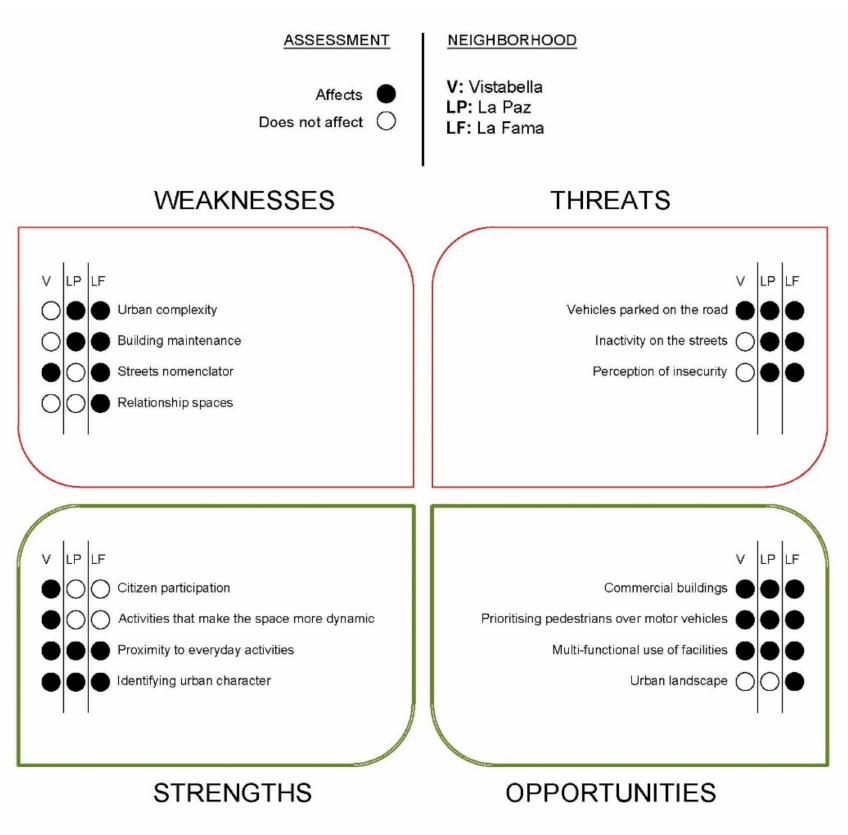
Figure 11. Strengths, weaknesses, opportunities and threats (SWOT) analysis. Authors’